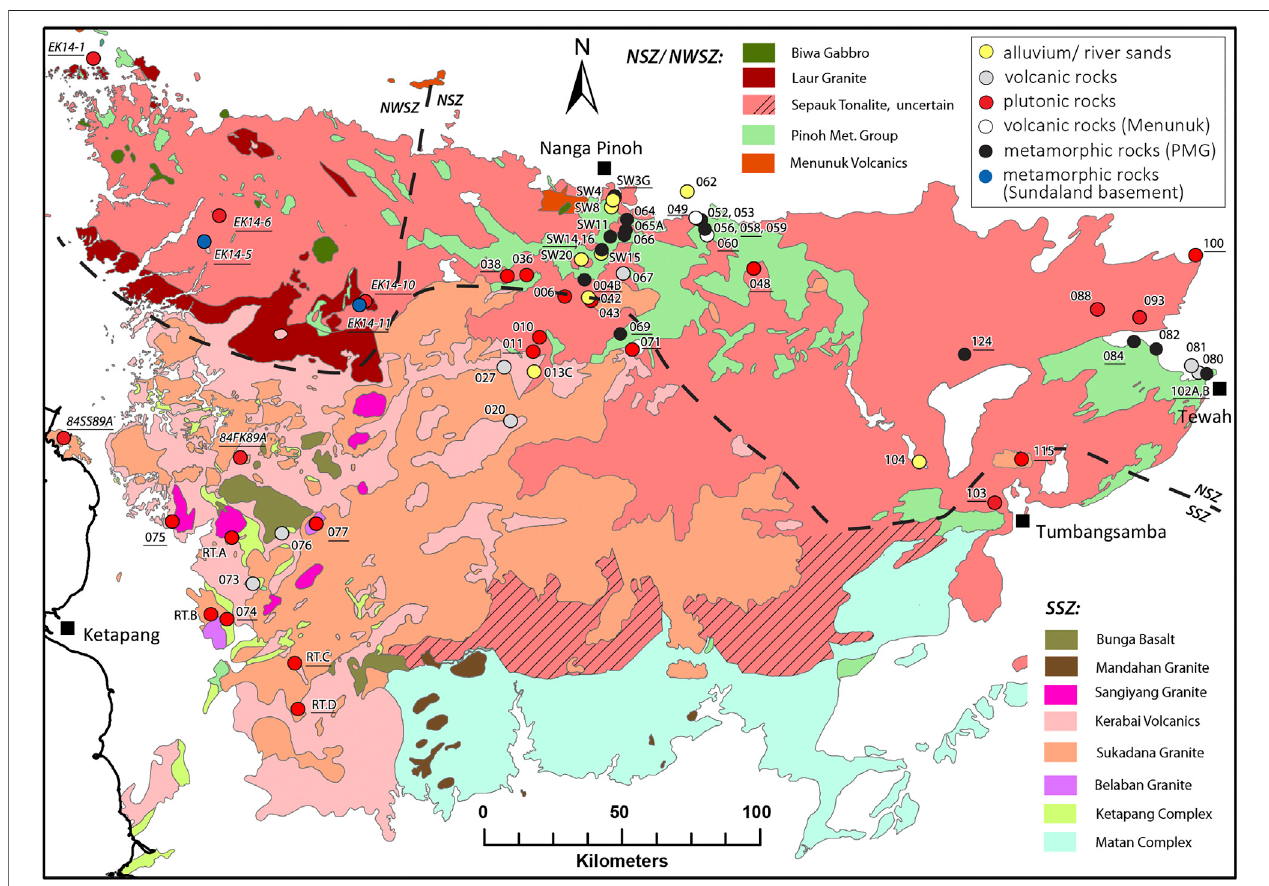
FIGURE 4 | Geological map of the Schwaner Mountains with sample locations, modi fi ed after Borneo maps of Pieters and Supriatna (1990) and Tate (2001). UnderlinedsamplesaredatedwithzirconU-Pbgeochronology.Italiclabelledsamplesareliteraturedata(Ketapangarea:DeKeyserandRustandi,1993;NWSZ:Hennig et al., 2017). Dashed lines indicate approximate boundaries of the NWSZ, NSZ and SSZ. The extent of plutons is inferred from geological maps. The distribution of the Sepauk Tonalite is possibly overestimated in the SSZ.